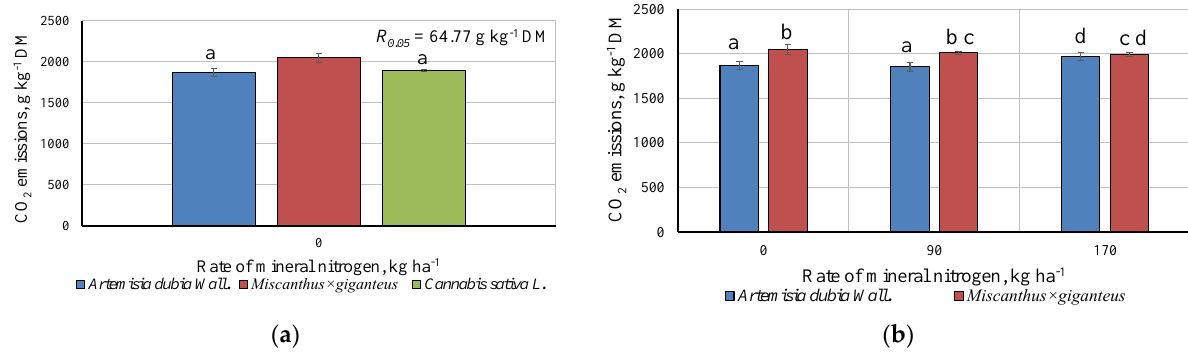
Figure 7. The dependence of CO 2 emissions of Artemisia dubia Wall., Miscanthus×giganteus and Cannabis sativa L. not fertilized ( a ), on mineral nitrogen fertilization ( b ) ( R 0.05 ( A. dubia ) = 73.56 g kg − 1 DM, R 0.05 ( M. giganteus ) = 53.09 g kg − 1 DM, R 0.05 ( A. dubia × M. giganteus ) = 50.83 g kg − 1 DM. a, b, c, d, there are no statistically significant differences ( p < 0.05) between the columns marked with the same letter, as assessed using the least significant difference.